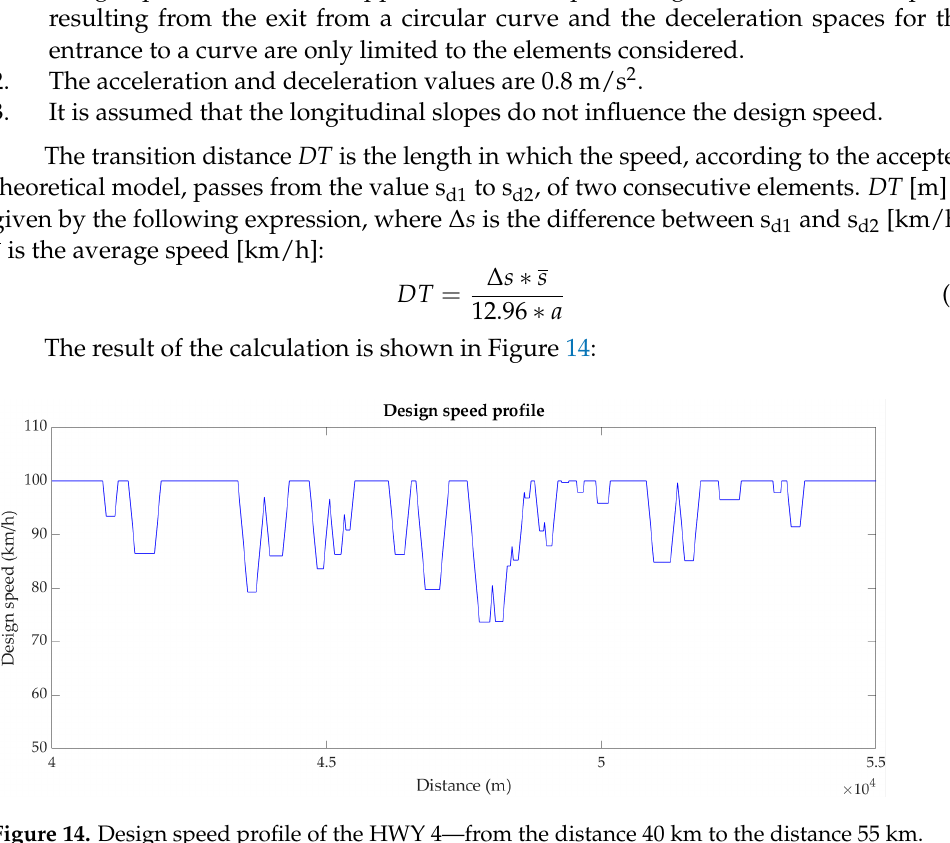
Figure 13. Curvature graph of the HWY 4—from the distance 40 km to the distance 55 km.